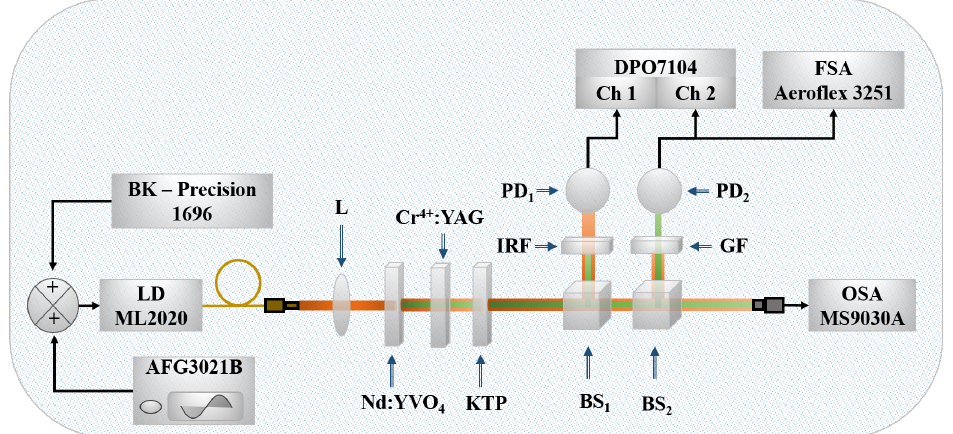
Figure 1. Schematic arrangement of the Nd : YVO 4 -KTP laser with a KTP crystal intracavity for second harmonic generation and modulated by an external